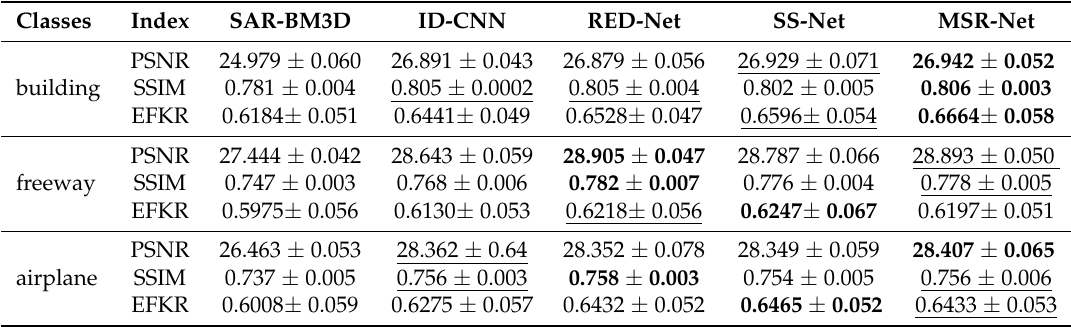
Table 4. The PSNR, SSIM, and EFKR of test set with the noise level L =